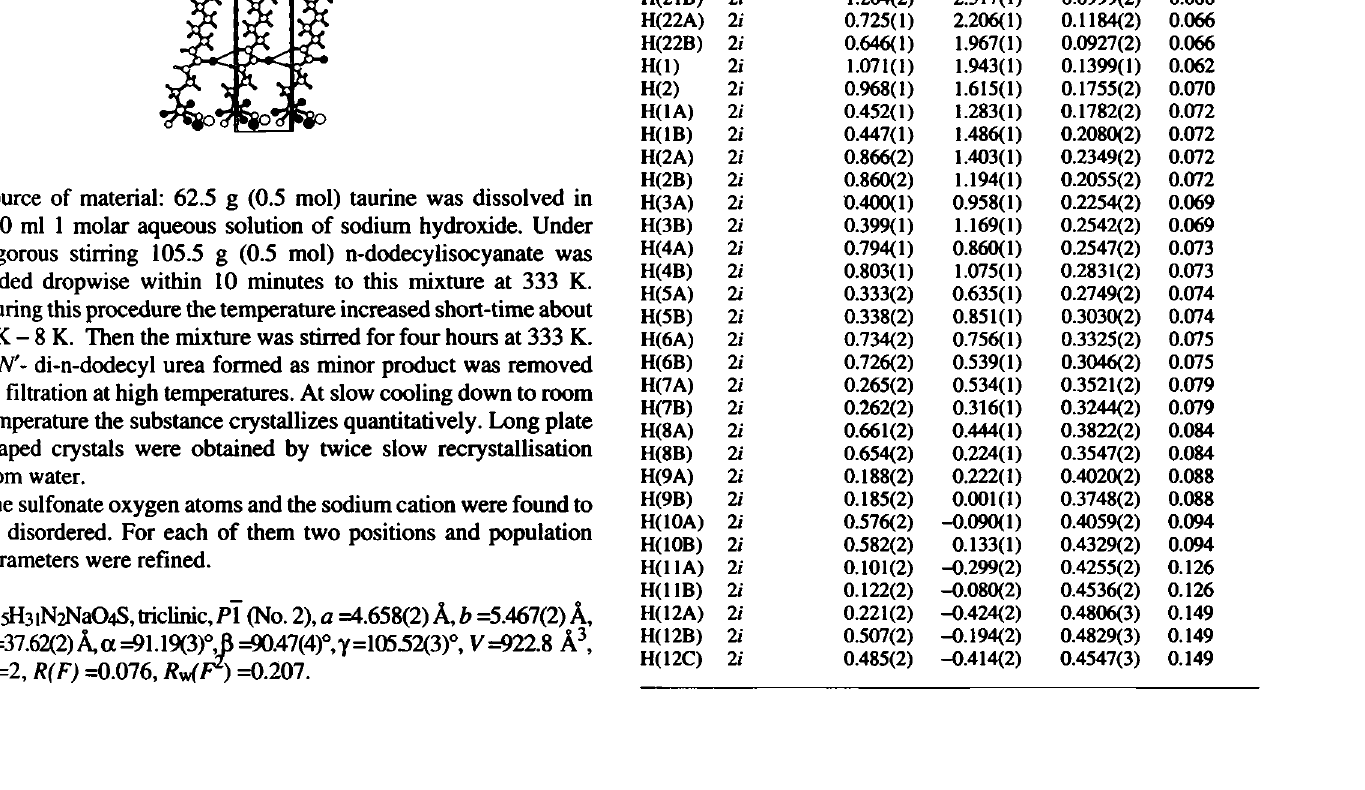
Table 2. Final atomic coordinates and displacement parameters (in